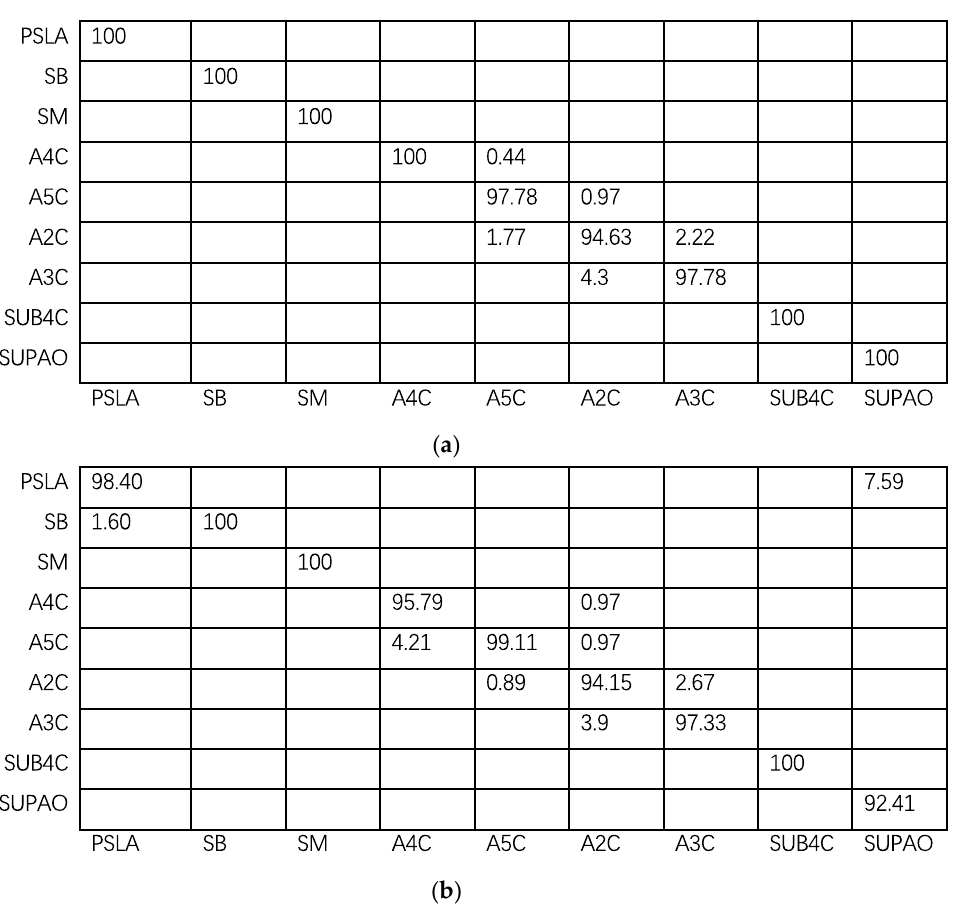
Figure 4. Confusion matrices. ( a ) Testing set in Dataset 1, ( b ) Testing set in Dataset 2.